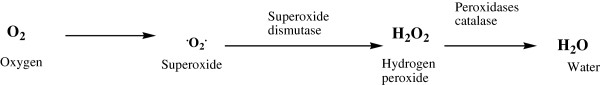
Enzymatic pathway for the detoxification of reactive oxygen species.